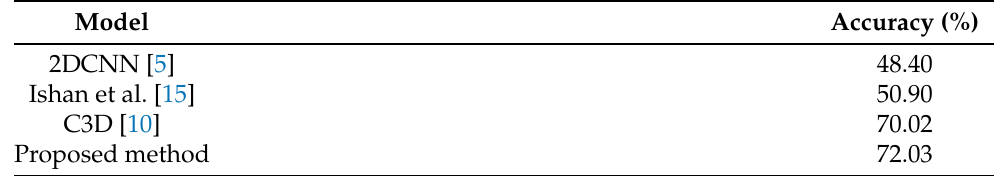
Table 3. Accuracy comparison in UCF101 dataset.